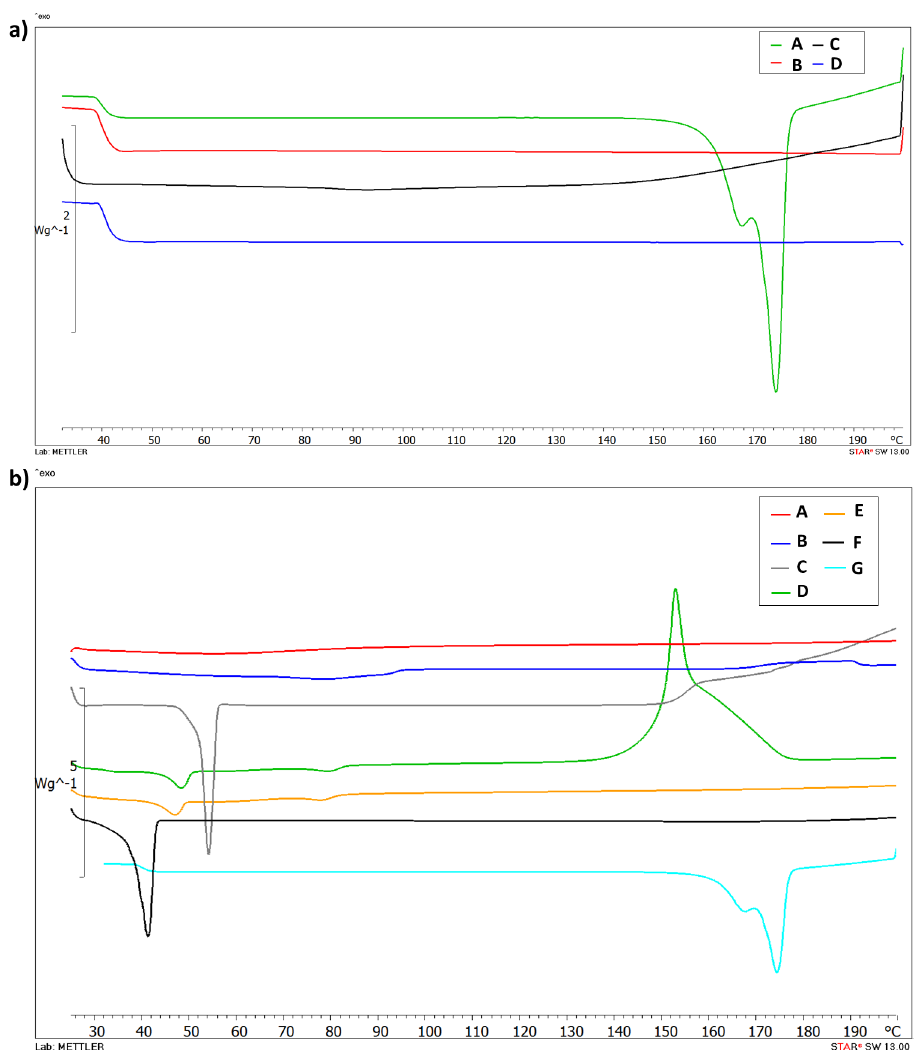
Figure 2. Differential scanning calorimetry (DSC) thermograms of PNP ( a ): Cur (A), PLGA (B), unloaded PNP (C), Cur-PNP (D) and SLN; ( b ): HPMC (A), soy lecithin (B), Lutrol F68 (C), unloaded SLN (D), Cur- SLN (E), Softisan (F) and Cur